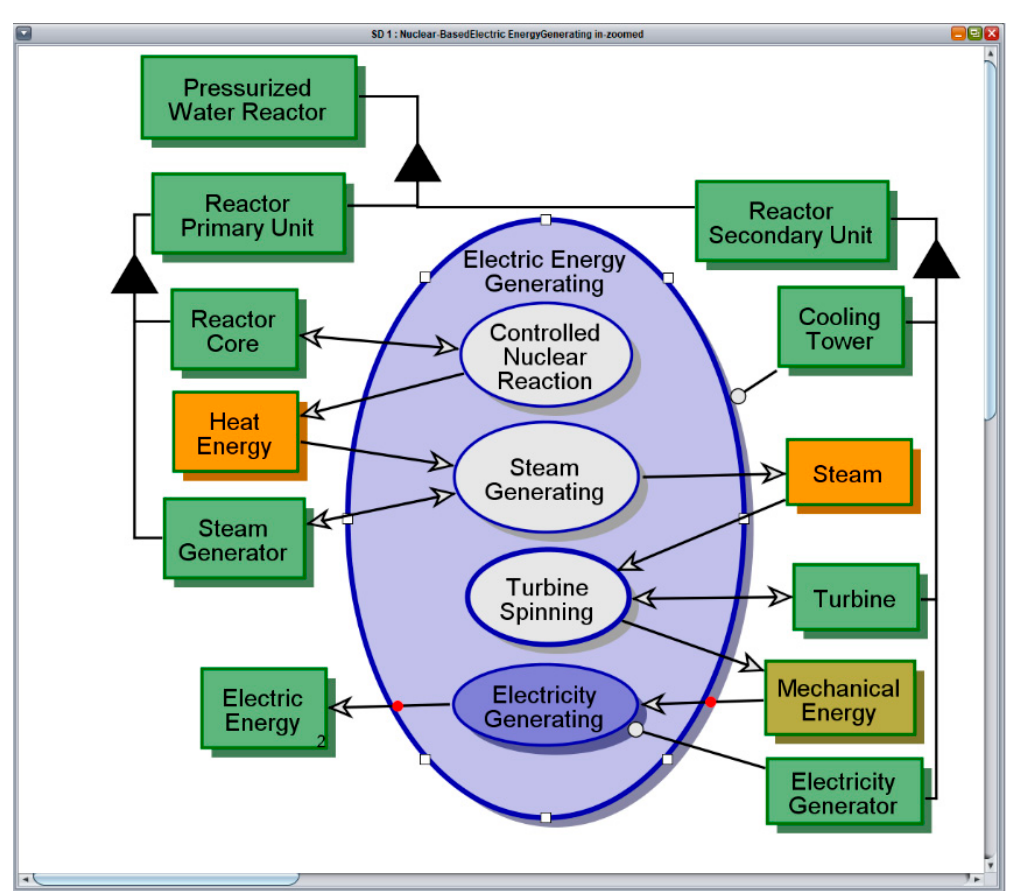
Figure 8. Electric Energy Generating using a pressurized water reactor—nominal operation.